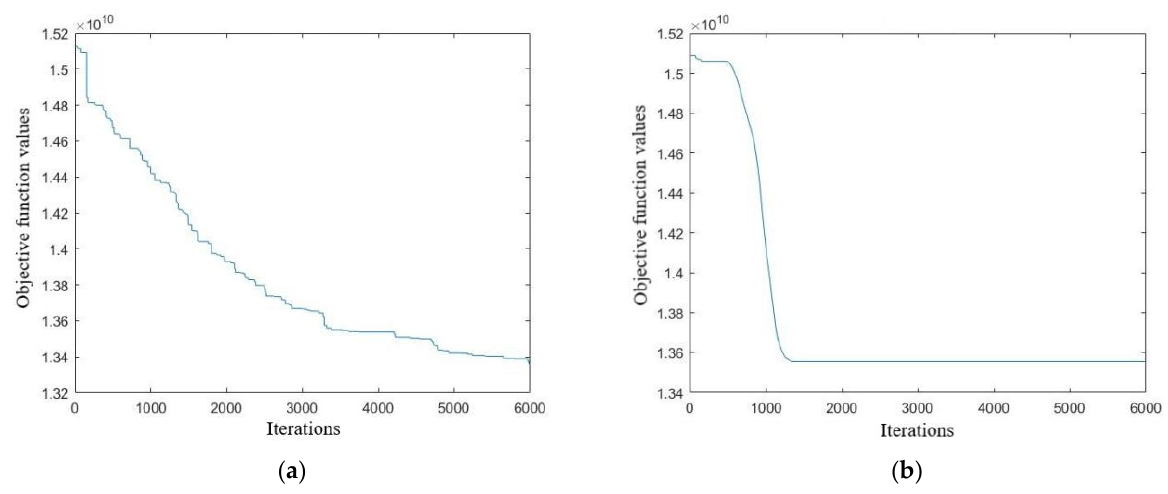
Figure 8. Convergence processes for the 13 August 1974 flood using the ( a ) SAPSO and ( b ) PSO algorithms.